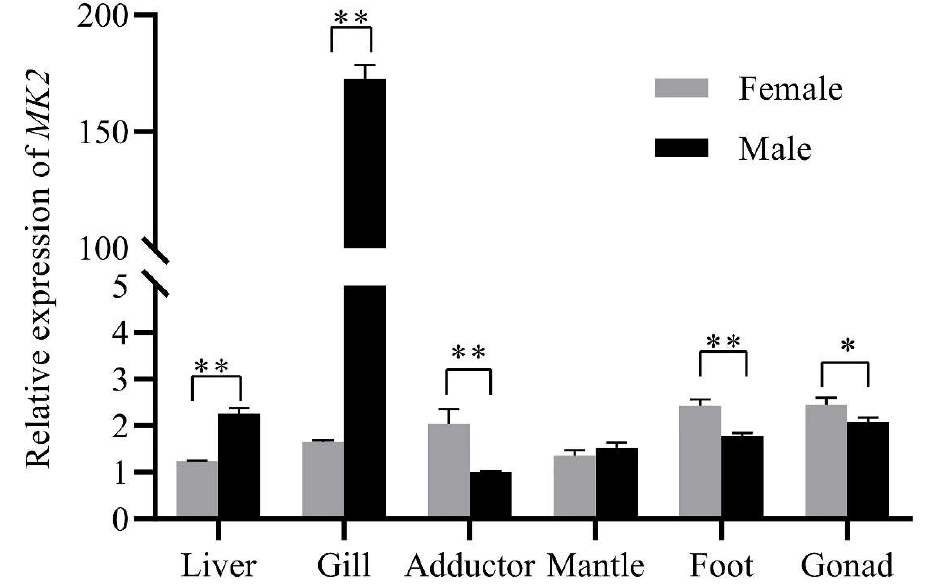
Figure 4. Relative expression of MK2 in different somatic tissues in female and male H. cumingii . EF1 α was selected as the internal reference gene, and the quantitative results all had three sets of biological replicates. The horizontal axis of the coordinates was the different tissues of H. cumingii , and the vertical axis is the relative expression of MK2 . The analysis of significance was marked with an asterisk. A single asterisk means there is a significant difference (* p < 0.05), and double asterisks mean a highly significant difference (** p < 0.01).